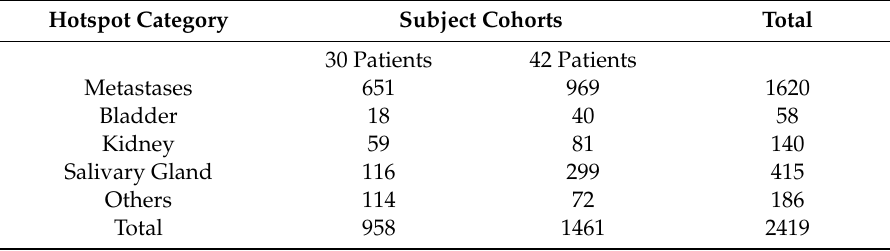
Table 2. Distribution of the 2419 annotated hotspots over di ff erent organs in the 72 patients.